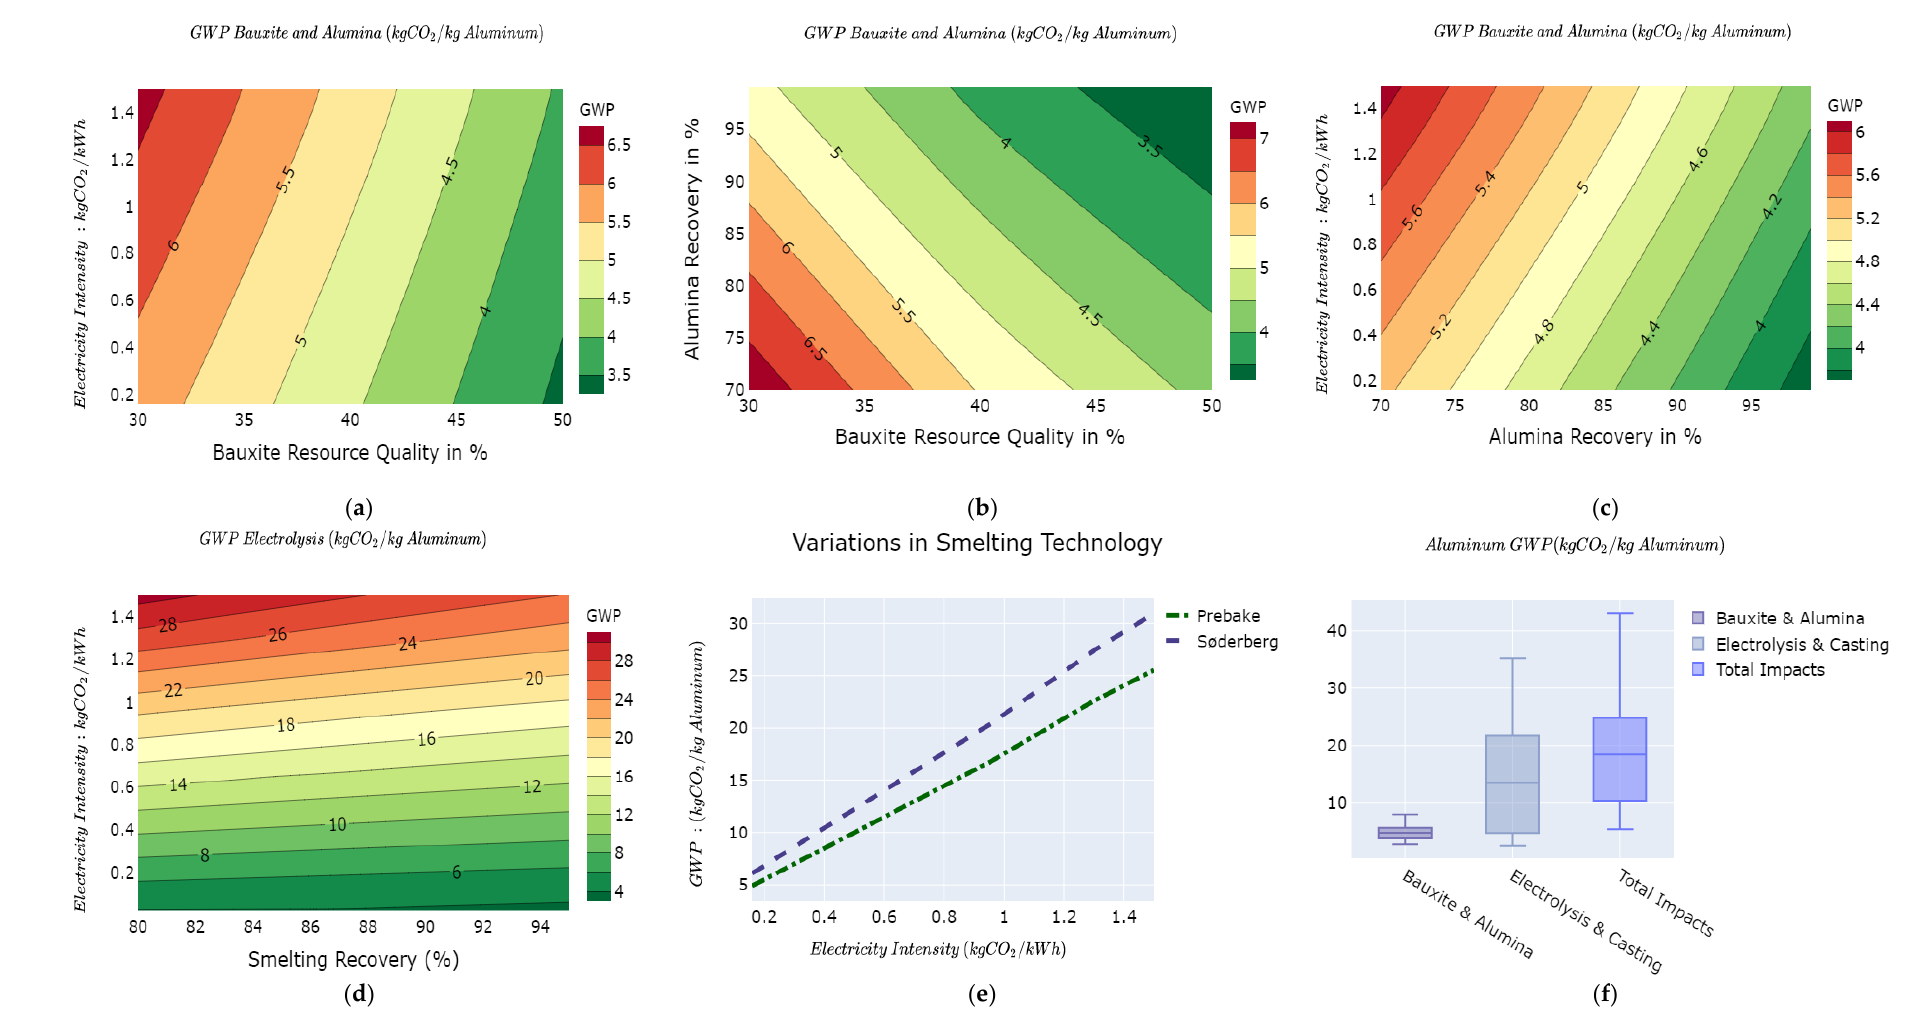
Figure 3. GWP variability in the aluminum value chain as a function of: ( a ) bauxite ore grade vs. electricity mix; ( b ) bauxite ore grade vs. alumina recovery, ( c ) alumina recovery vs. electricity mix intensity, ( d ) smelting recovery vs. electricity mix intensity; ( e ) smelting technology vs. electricity mix intensity; and ( f ) overall GWP variations across aluminum value chain.